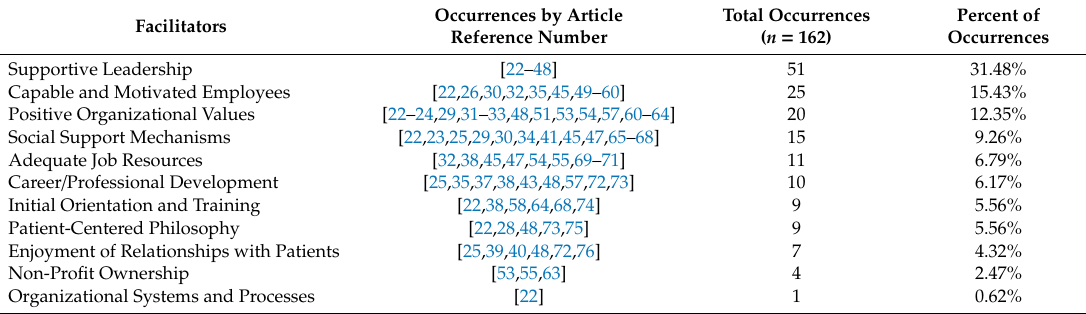
Table 1. Summary and frequency of facilitators identified as impacting on job satisfaction.